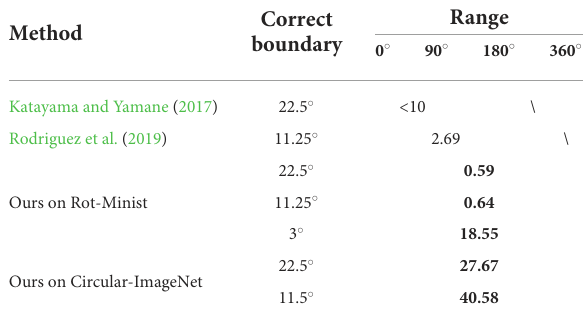
TABLE 3 Comparison of error rate (%) with other